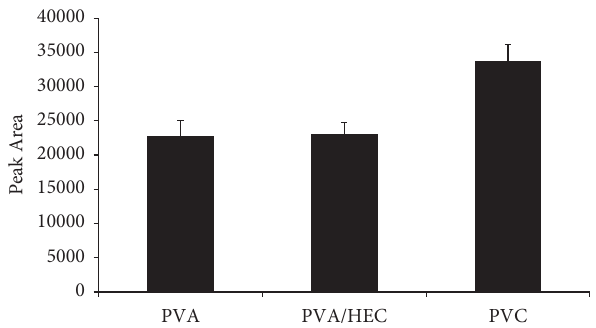
Figure 5: Effect of the nanostructured membrane type on extraction efficiency. Extraction conditions: extraction time 30min, desorption time 30min with 0.01M sulfuric acid as the desorption solvent, and sample volume 10mL; no adjustment of sample pH.